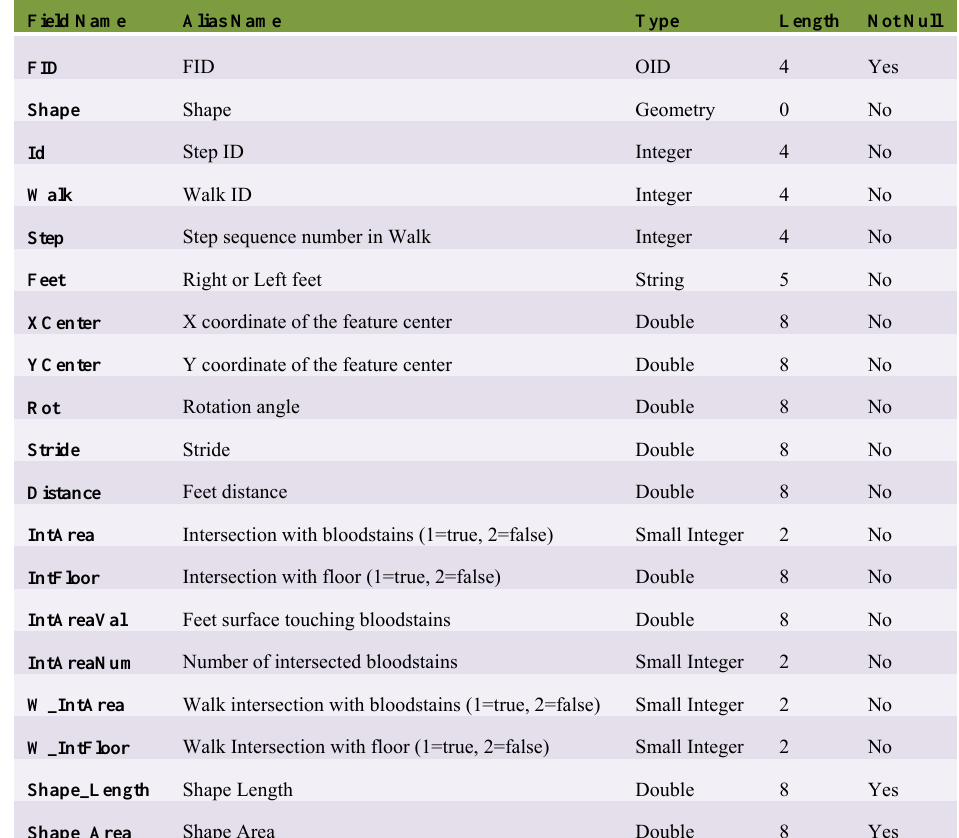
Table 1. Single steps attributes and their